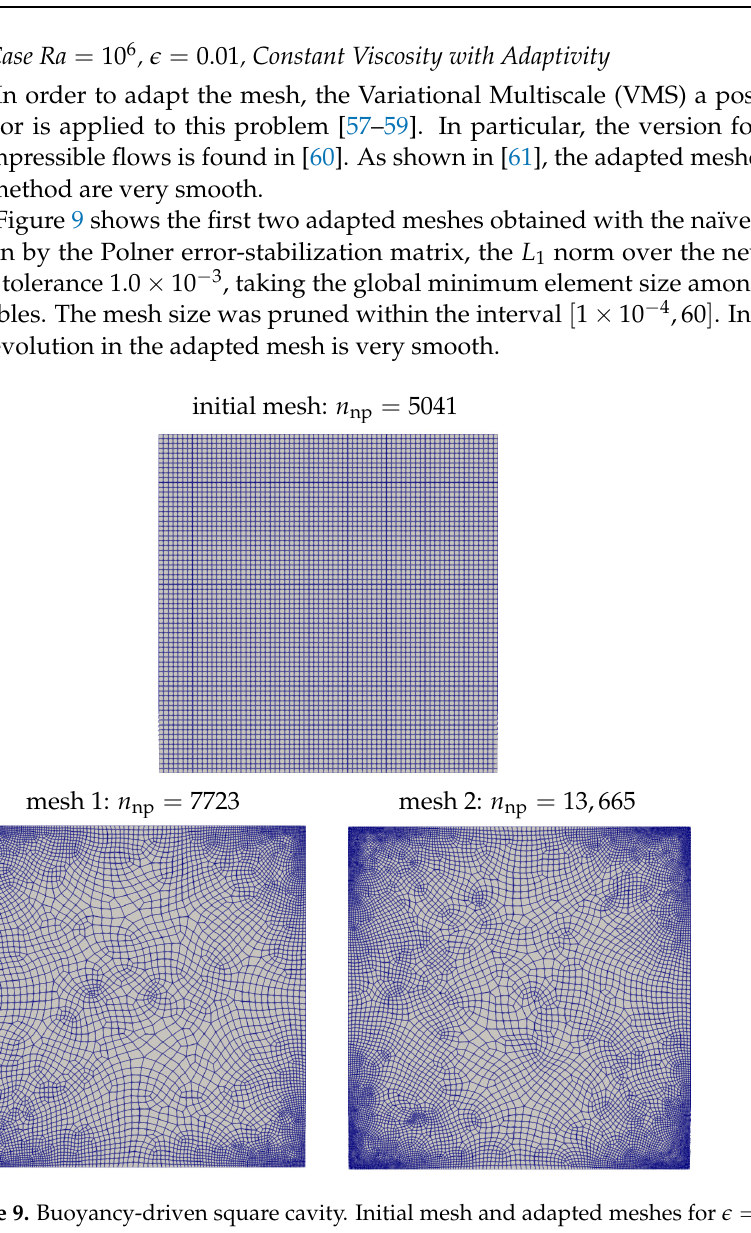
Figure 9. Buoyancy-driven square cavity. Initial mesh and adapted meshes for (cid:101) =